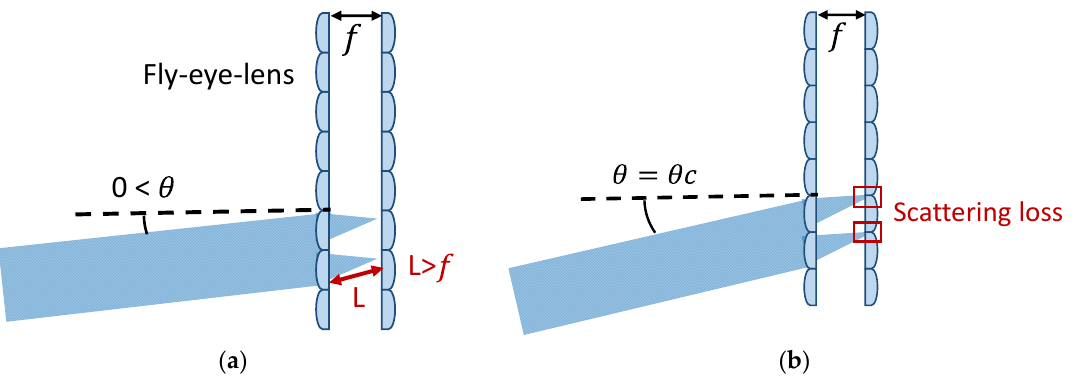
Figure 12. Issues with oblique incidence on the fly-eye lens. ( a ) difference between optical path length L and focal length f , and ( b ) scattering loss at the boundary of the elemental lens.